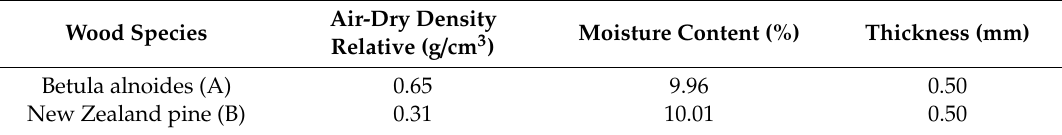
Table 1. Physical properties of two tree species.